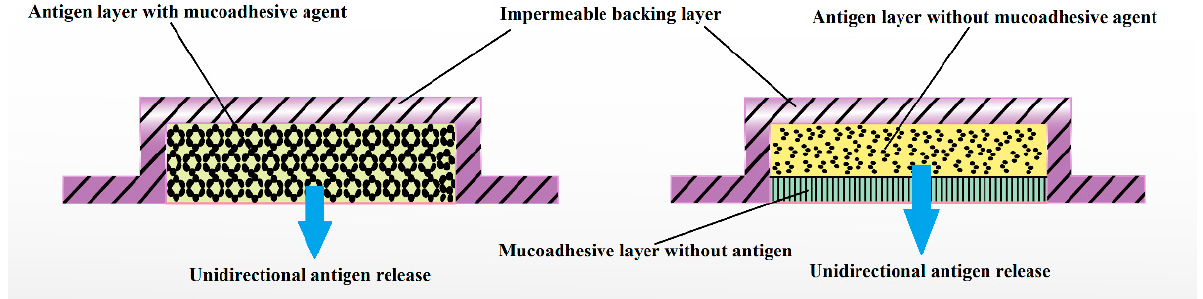
Figure 3. Possible designs of multilayered vaccine comprised buccal film with different functions for unidirectional release of antigen.